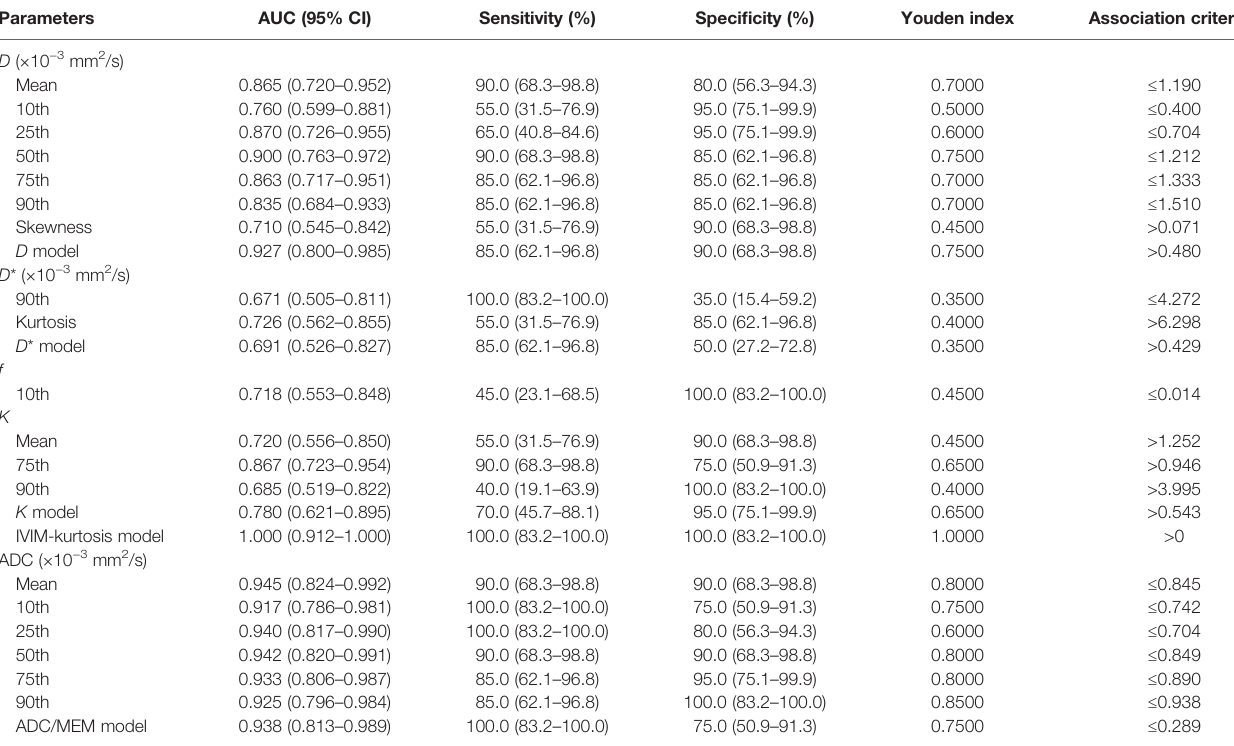
TABLE 4 | The results of ROC analysis for mean values and histogram parameters.